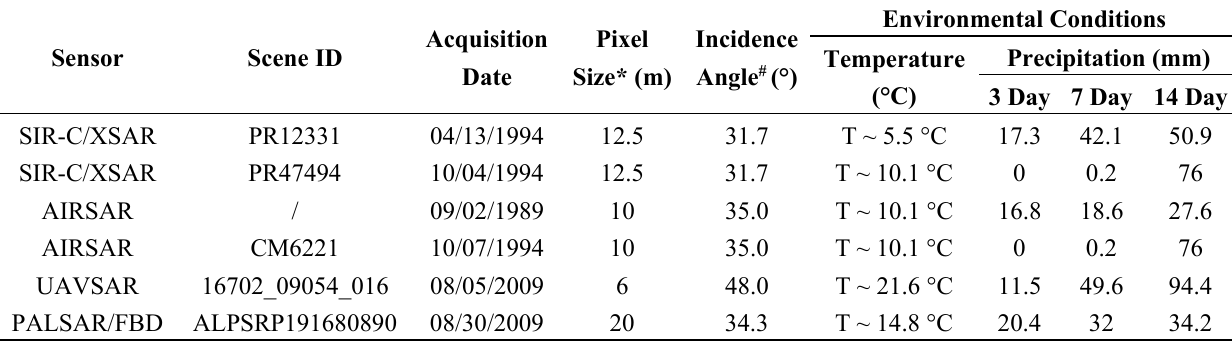
Table 1. SAR data selected for sensitivity analysis. *Pixel size for the multi-looked ground-projected product. # incidence angles are at scene center; for technical specifications see